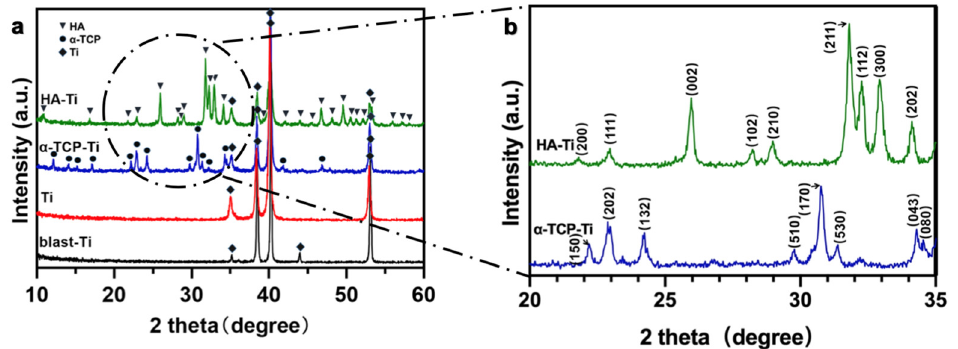
Figure 7. ( a ) X-ray diffraction patterns of Ti, blast-Ti, α -TCP-Ti, and HA-Ti discs. ( b ) Magnification of the spectra of α -TCP-Ti (blue) and HA-Ti (green) marked by the black circle in ( a ).